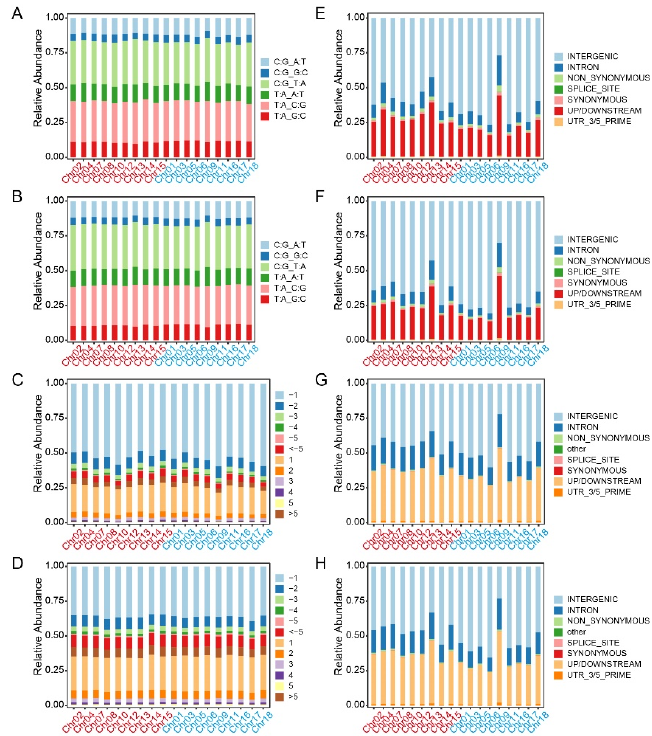
Figure 4. Stacked bar charts of total variations in each of Longli-4 and CA3-1. ( A – B ) SNP variations are categorized into six groups based on transitions and transversions, and the percentage of each group on each chromosome in Longli-4 ( A ) and CA3-1 ( B ) is presented as a stacked bar. ( C – D ) INDELs including insertions and deletions are classified into twelve groups based on reference genome information, and proportions of twelve groups on each chromosome in Longli-4 ( C ) and CA3-1 ( D ) are both stacked as 100%. ( E – H ) SNPs ( E , F ) and INDELs ( G , H ) are categorized into seven groups based on annotation, and relative abundance values of seven groups on each chromosome in Longli-4 ( E,G ) and CA3-1 ( F,H ) are shown as a stacked bar. The chromosomes from the A and B sub-genomes of quinoa are shown as those in Figure